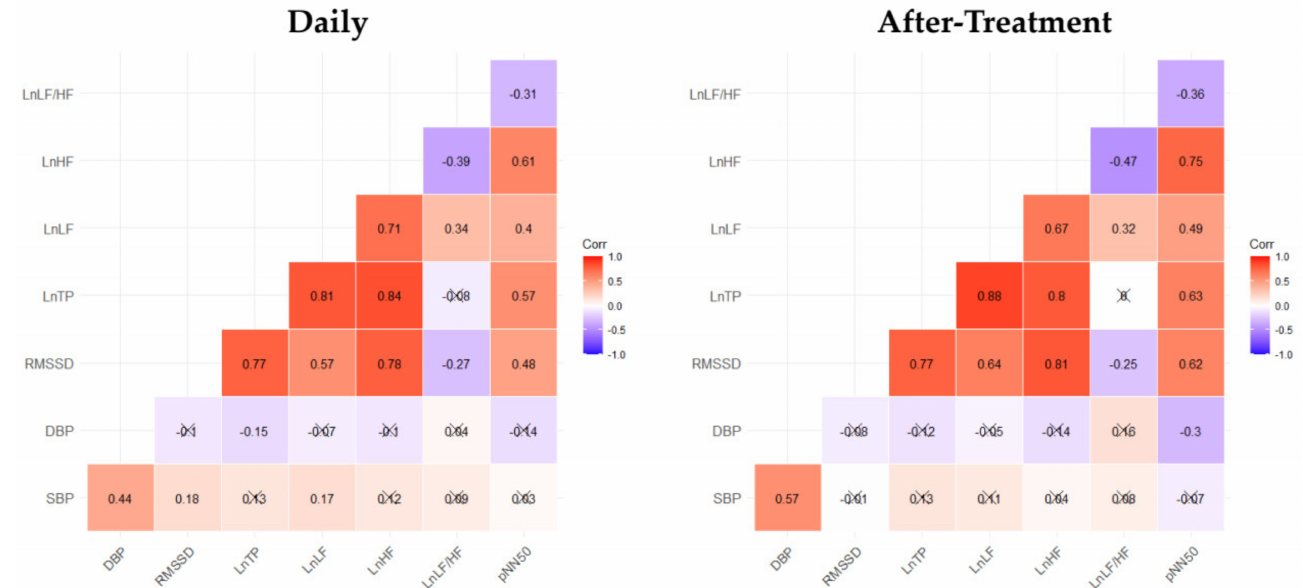
Figure 5. Pearson’s correlation coefficient results for blood pressure and autonomic nervous system related indicators. Cells marked with X indicate that the correlation coefficient is not significant ( p > 0.05). Daily analysis includes pre-treatment and follow-up test results, and after-treatment analysis includes post-treatment